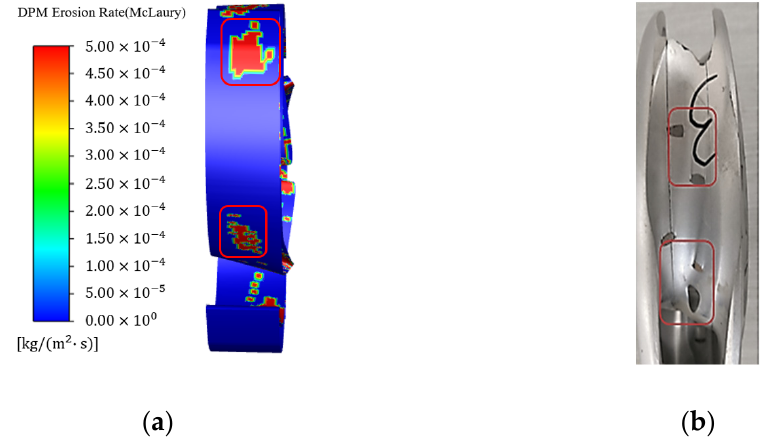
Figure 7. Wear comparison at blade pressure surface: ( a ) simulation; ( b ) experiment.